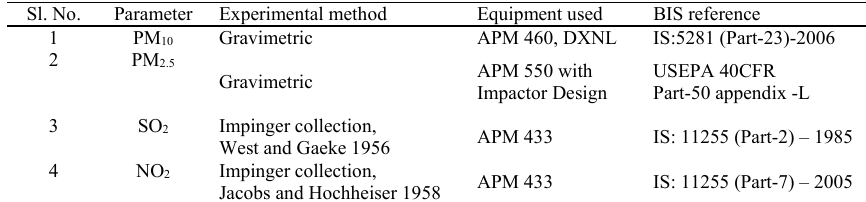
Table 2: Experimental methods of different parameters Sl. No.